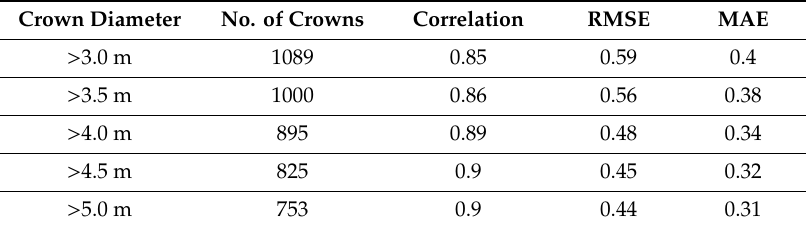
Table 3. Test of di ff erent minimum crown diameters for WV2 attributes for all crowns for seven stress levels. In addition to eight WV2 attributes, the maximum crown height value was included for crown stratification. The performance was tested with a random forest (RF) regression with three random folds in 1000 repetitions and a depth of 8.